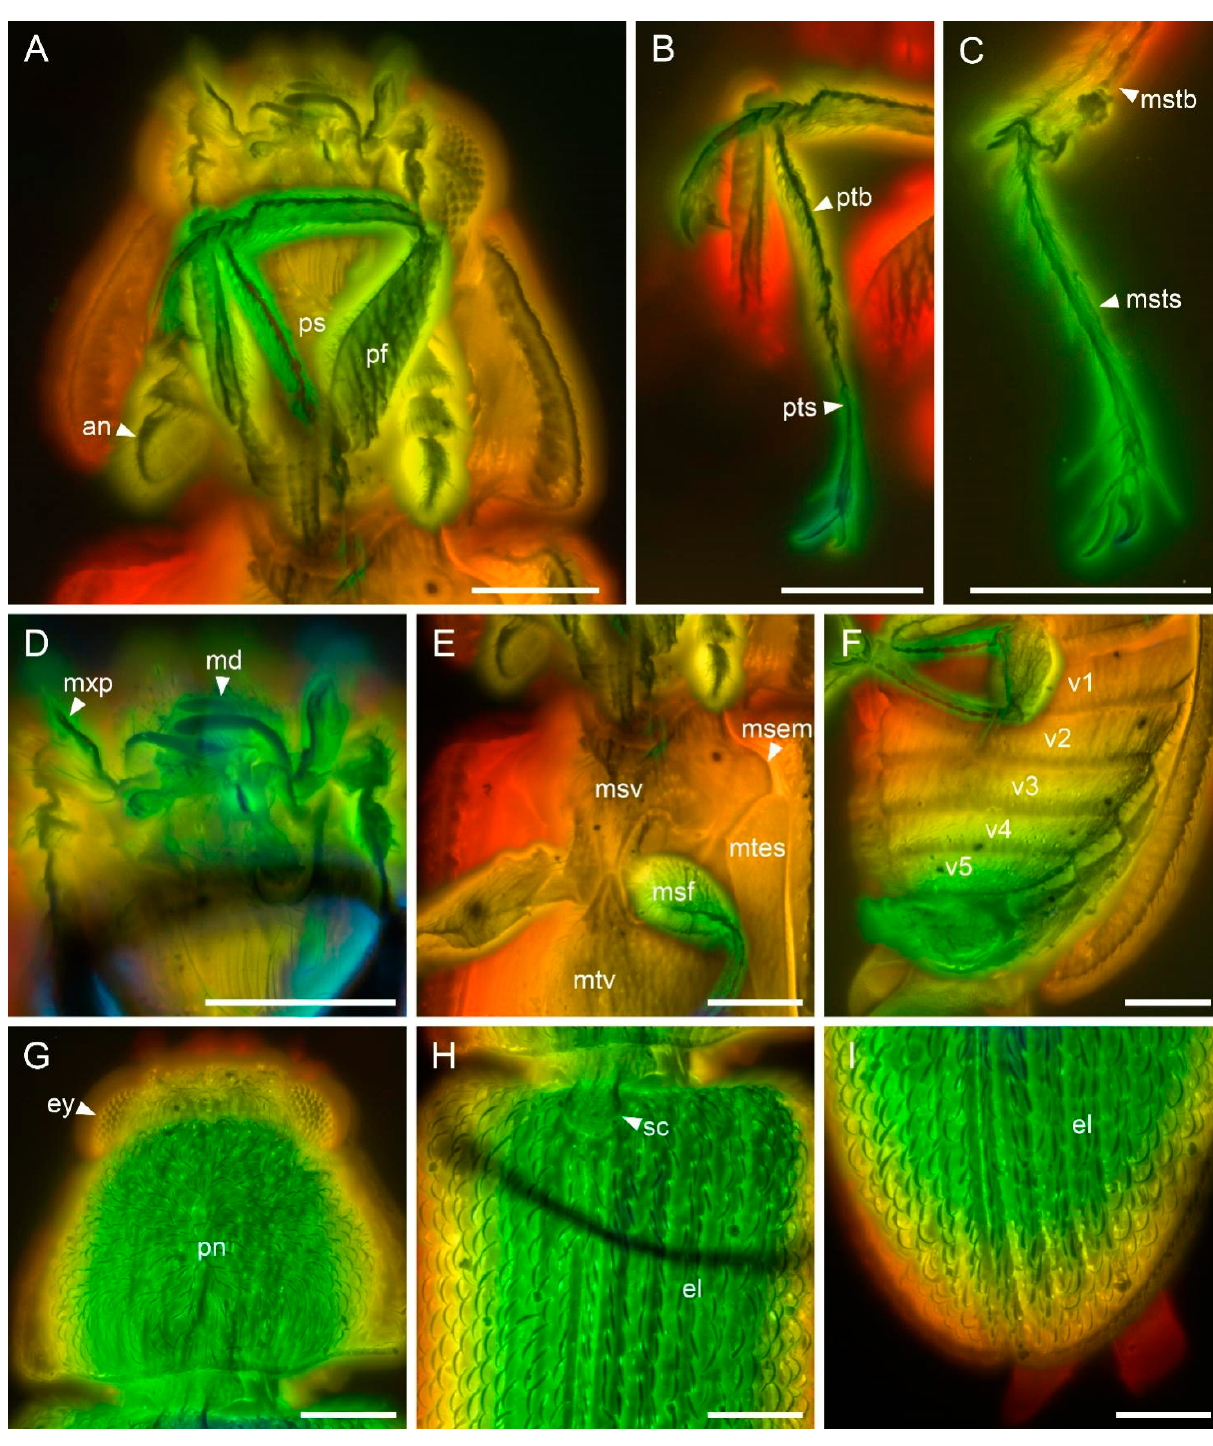
Figure 4. Details of Gracilenticrus burmiticus gen. et sp. nov., under confocal microscopy, with depth color coding. Dorsal views in ( G – I ), ventral views in ( A – F ). ( A ) Head and prothorax. ( B ) Protibiae and -tarsi. ( C ) Left mesotarsus. ( D ) Mouth-